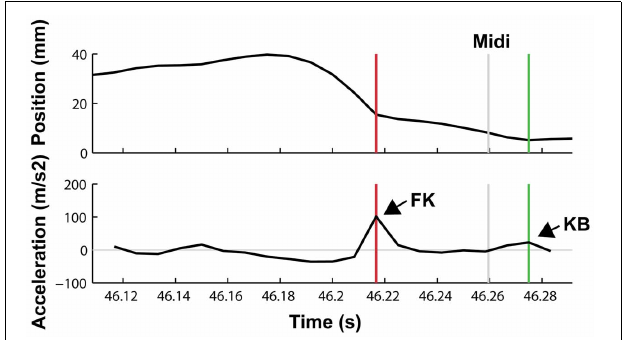
FIGURE 2 | Vertical motion of the fingertip of a pianist’s ring finger playing the G#5 key. Upper panel: finger position, lower panel: acceleration. An acceleration peak can be observed around 40ms prior to the MIDI note onset, occurring when the fingertip makes initial contact with the key surface (finger-key landmark, FK). Shortly after the MIDI onset, another acceleration peak occurs when the key reaches the key bed after key depression (key-bottom landmark,